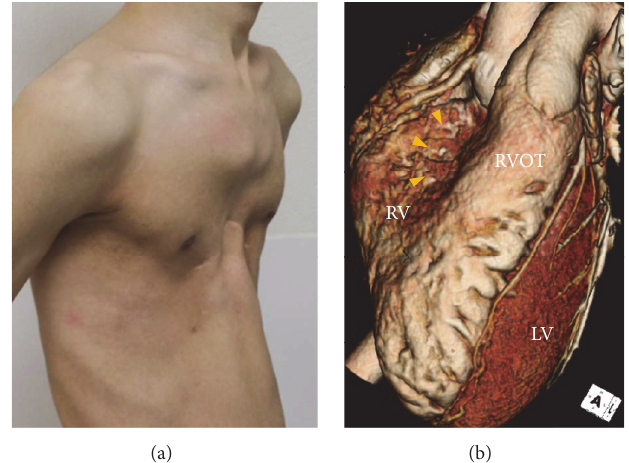
Figure 1: (a) Gross picture shows a deformity of the anterior thoracic cage consistent with pectus excavatum. (b) 3D reconstructed computed tomography image also reveals external compression of basal-to-mid portion of the right ventricle (yellow arrow heads). LV, left ventricle; RV, right ventricle; RVOT, right ventricular outflow tract.